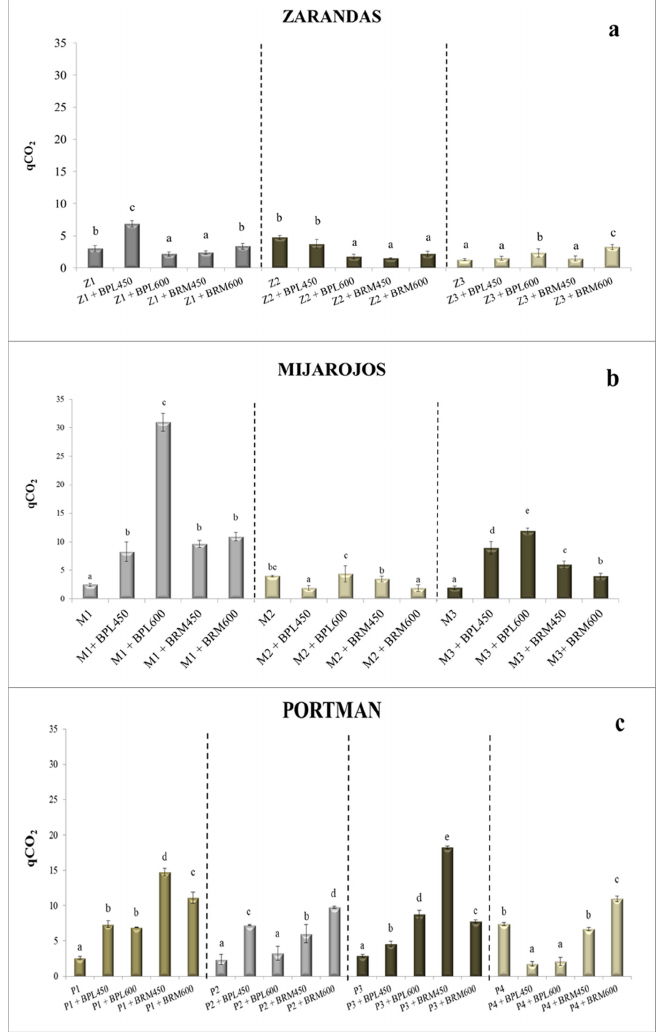
Figure 3. qCO 2 of all treatments after 180 days: a ) Zarandas-Andalusia area. b ) Mijarojos-Cantabria area. c ) Portman-area.